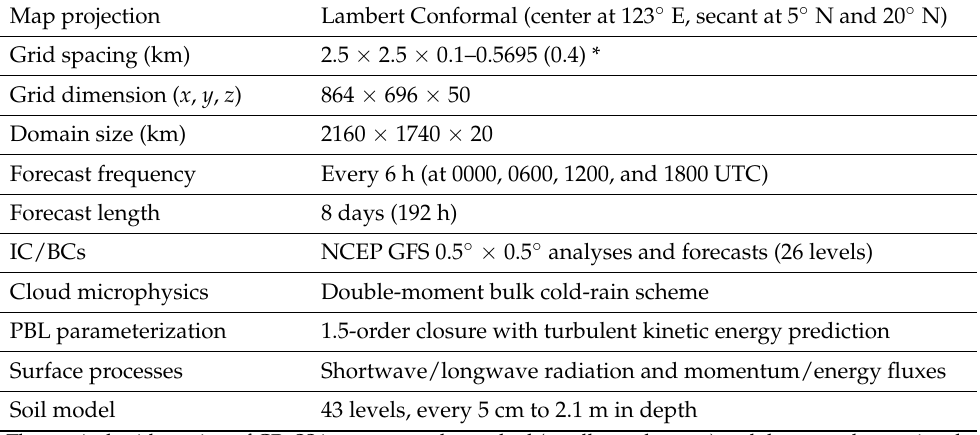
Table 1. The basic domain configuration and physical packages of the 2.5 km CReSS in this study. Map